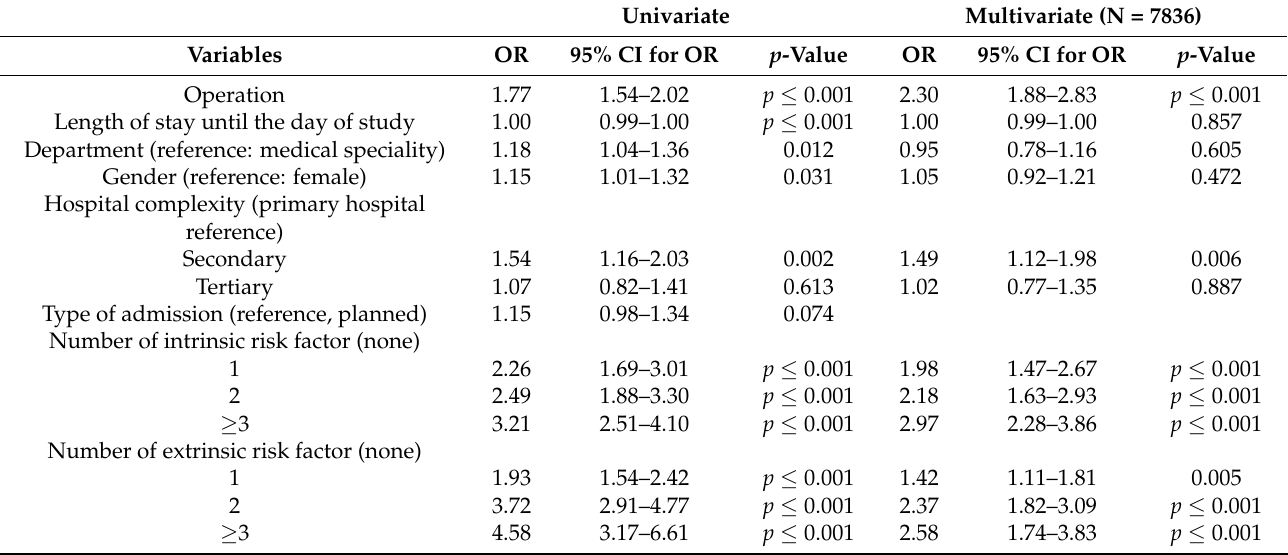
Table 5. Univariate and multivariate logistic